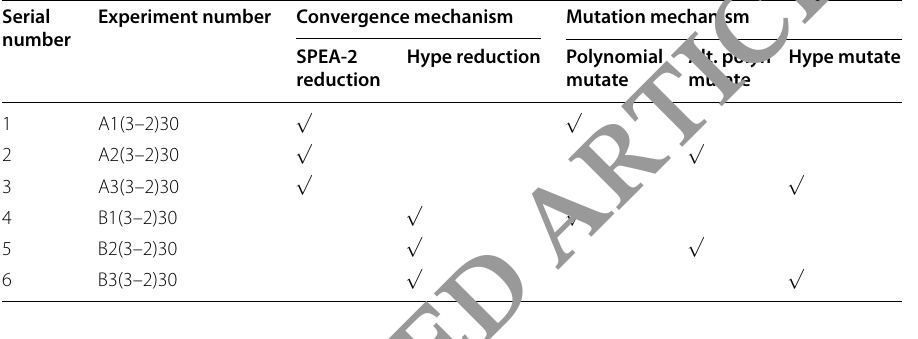
Table 2 Experiment 1–6 algorithm mechanism